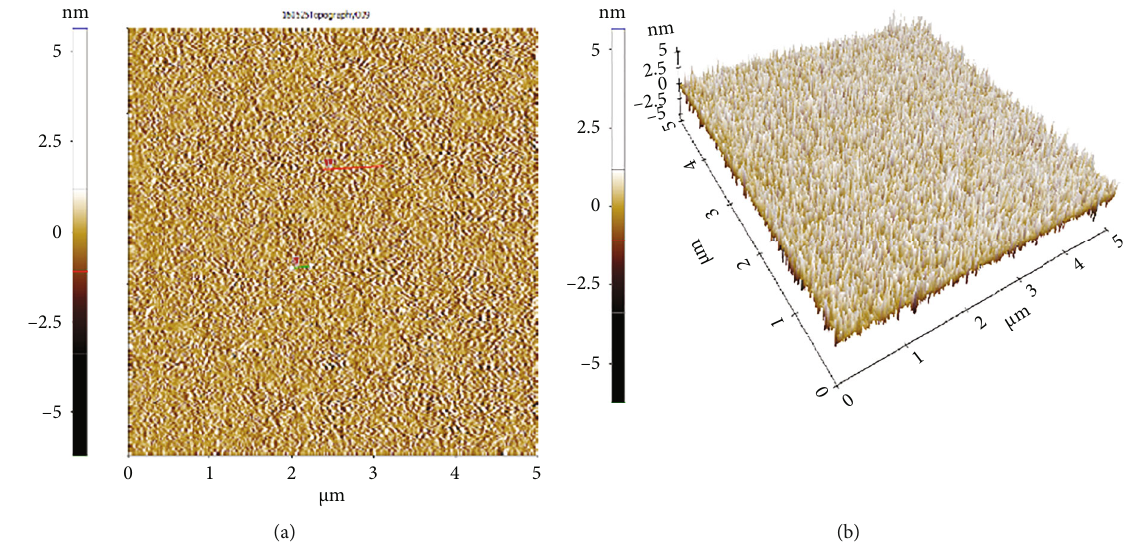
Figure 7: AFM images of CFA ferrospheres: (a) 2D and (b) 3D.